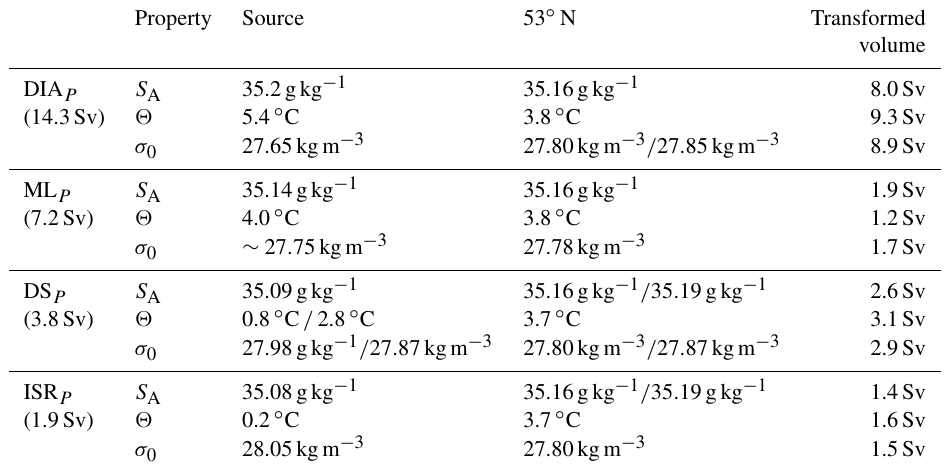
Table 3. Mean water mass property modifications of the four particle categories DIA P , ML P , DS P , and ISR P (see Sect. 2.1.3 for details of the definitions). Listed are potential density (referenced to 0dbar, σ 0 ), absolute salinity ( S A ), conservative temperature ( (cid:50) ), and the transformed volume (in Sv) from the source to 53 ◦ N (target section). When values are presented with “/”, two major classes of properties are persistent for this particle